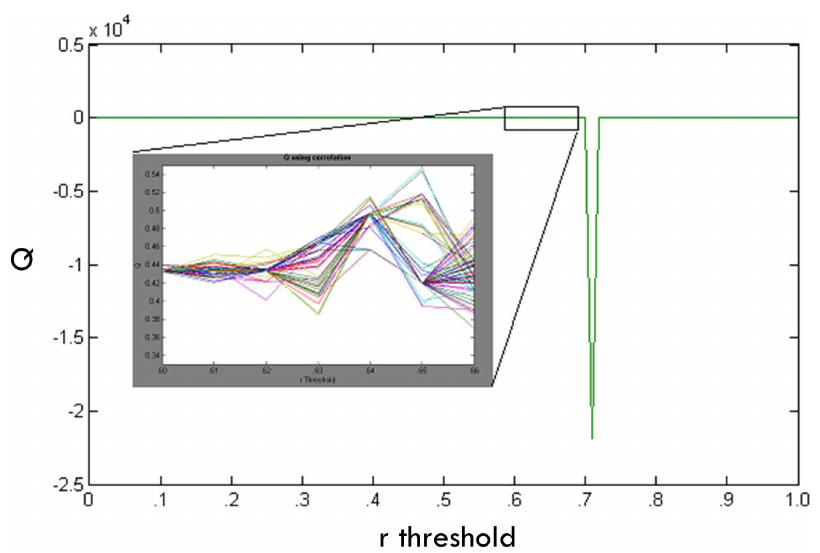
Figure 3. Q index and reachability across thresholds. Q values across all thresholds (top panel); average number of individuals each individual can reach at each threshold (i.e., reachability) and visual depiction (grey, dotted lines) of approach for defining the point at which reachability begins to decrease (middle panel); Q values (bottom panel) up until drop in reachability (denoted with a red circle in the middle panel). The optimal r thresholds with maximum stability, Q index value, and reachability criteria were .60 and .56 for the simulated data example presented here (1 of 100 runs) and empirical data, respectively.